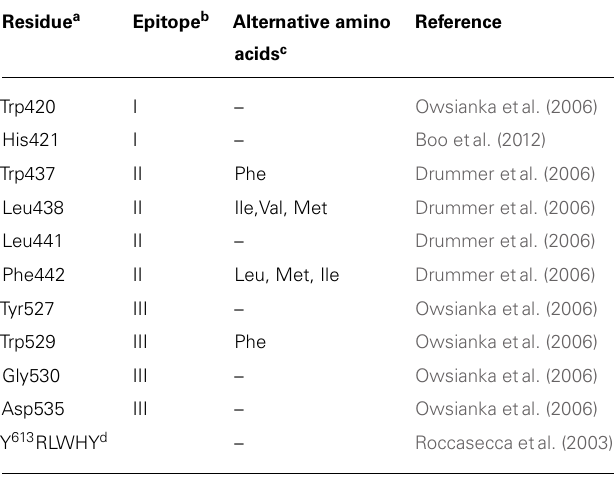
Table 1 | Residues of E2 involved in binding to